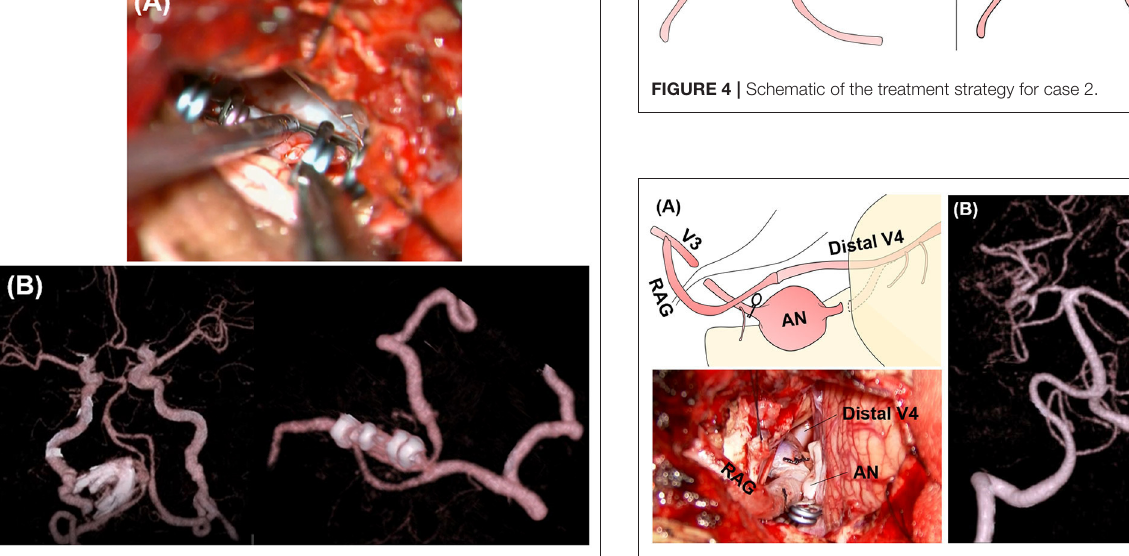
FIGURE 5 | Intraoperative findings and postoperative computed tomography angiography (CTA) of case 2. (A) Intraoperative microscopic image and its schematic. (B) Postoperative